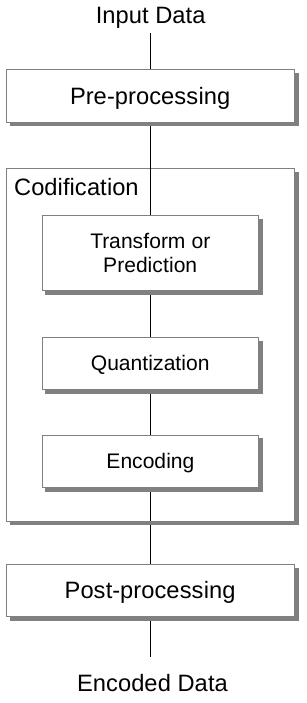
Figure 6. Data compression systems are usually composed of three main stages: pre-processing, coding, and post-processing. The coding stage may, in turn, comprise three steps: either transform or prediction, quantization, and encoding. Only the encoding process is displayed; decoding proceeds in reverse